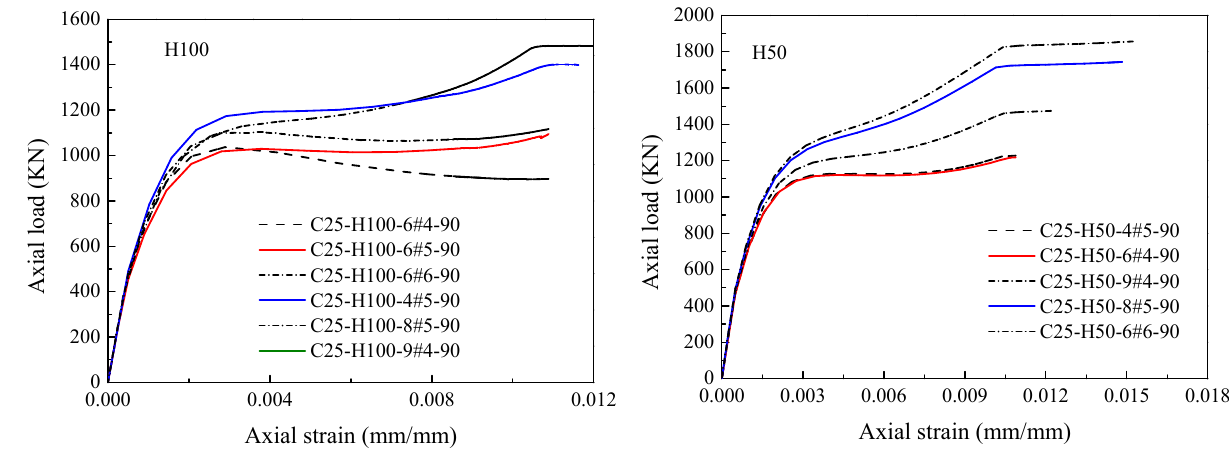
Figure 22. Effect of different amounts of longitudinal reinforcement on the load-strain response of HCCs.